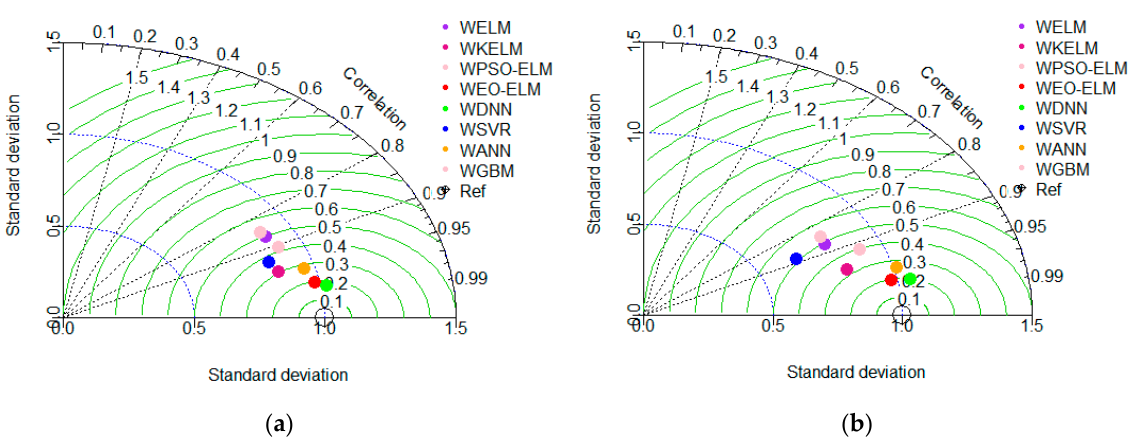
Figure 16. Statistical comparison for all models for catchment Fal at Tregony: ( a ) Train, and ( b ) Test. The performance of the wavelet-based models for the catchment Teifi at Glanteifi is shown in Table 6. It is apparent that the proposed WDNN exhibits better prediction in train and test phase compared to others in terms of all measured matrices (Table 6). For this catchment, the prediction accuracy of WEO-ELM follows WDNN and better compared to WKELM, WPSO-ELM, WELM, WANN, WSVR, and WGBM (Table 6). It is evident from Table 6 that WDNN model with rank 48 in both training and testing (having MAE = 2.65, MAPE = 13.75, NSE = 0.98, R2 = 0.98, RMSE = 4.26, VAF = 98.36 in training and MAE = 3.96, MAPE = 17.21, NSE = 0.98, R2 = 0.97, RMSE = 6.65, VAF = 97.20 in testing) achieved better results as compared to WEO-ELM model with rank 40 in both training and testing (having MAE = 3.88, MAPE = 21.58, NSE = 0.96, R2 = 0.96, RMSE = 6.52, VAF = 95.99 in training and MAE = 5.12, MAPE = 25.49, NSE = 0.97, R2 = 0.96, RMSE = 8.44, VAF = 95.67 in testing). Figures 17 and 18 exhibit better prediction performance WDNN in train and test case respectively compared to other models with their linear equations for predicted and measured values. Interestingly, the EO algorithm adequately optimized ELM parameters than the PSO algorithm and enhanced the performance of ELM sufficiently compared to PSO. The Taylor plot (Figure 19a,b) confirms the better prediction performance of WDNN followed by WEO-ELM in terms of statistical comparison of all models. Table 6. Wavelet-based models’ performance of the catchment Teifi at Glanteifi. MAE MAPE NSE